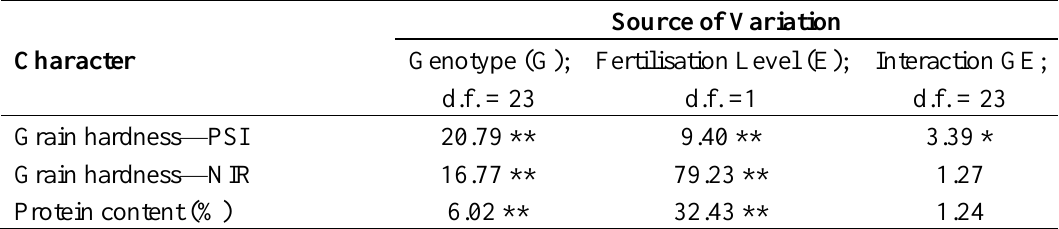
Table 3. F statistic values from two-way analysis of variance for grain hardness and quality characters of wheat lines assessed at two fertilization